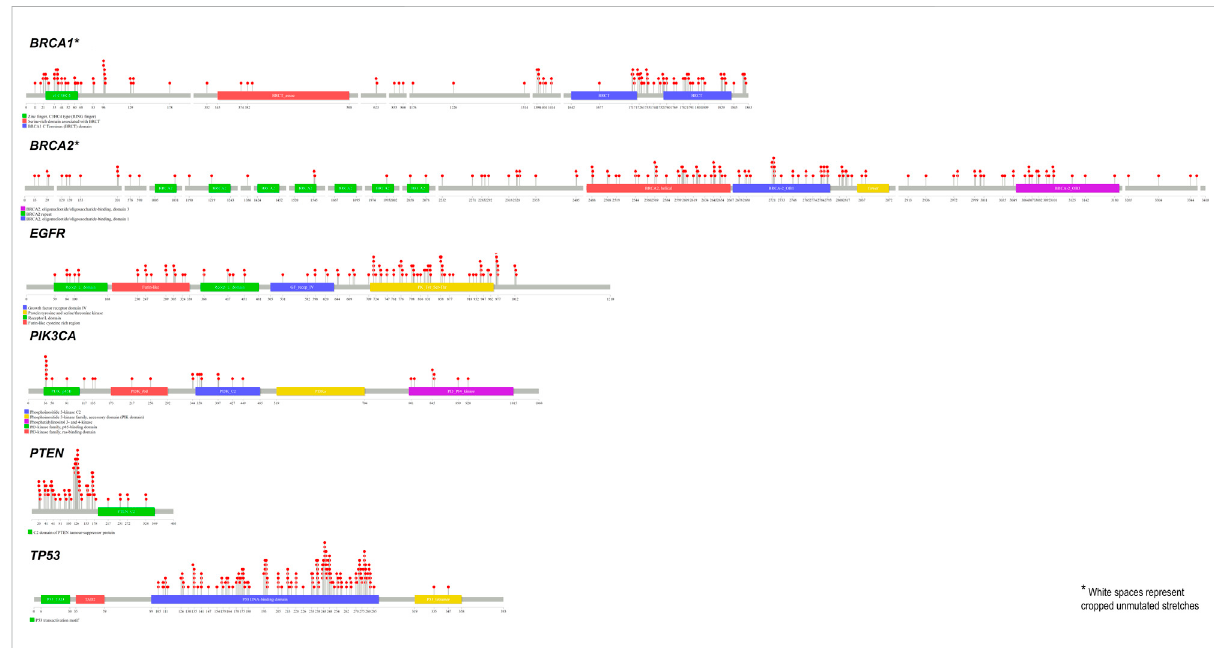
FIGURE 4 Lollipop plot for the alterations that were typed pathogenic by all the predictors.